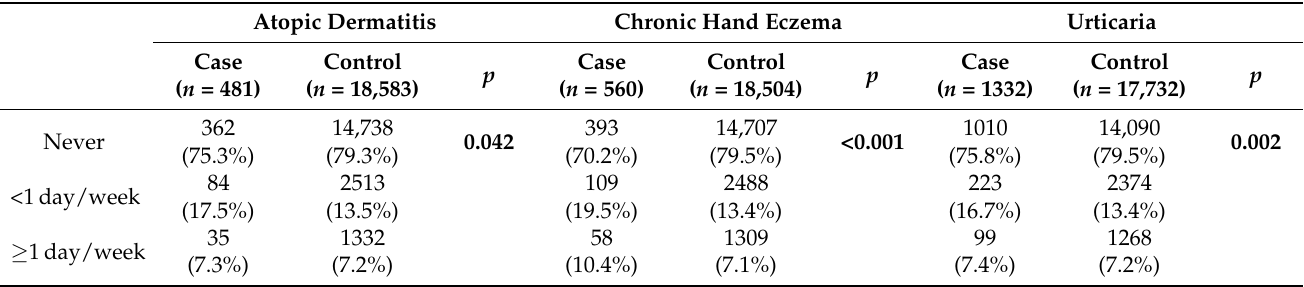
Figure 3. Association between urticaria and adjusted daily dose of ambient air pollutants. The unad- justed model describes the crude OR; the adjusted model was adjusted for demographic variables, behavioral habits, and environmental factors. * 0.01 < p < 0.05; ** 0.001 < p < 0.01; *** p < 0.001. Table 3. Association of second-hand smoke with inflammatory skin diseases. The association of second-hand smoke (SHS) with AD, CHE, and urticaria was ana- lyzed. Notably, a higher frequency of SHS exposure was positively correlated with the Atopic Dermatitis Chronic Hand Eczema prevalence of all three diseases (Table 3). Other covariates including sex, family income, BMI, and bath frequency for AD, CHE, and urticaria are shown in Table S2.